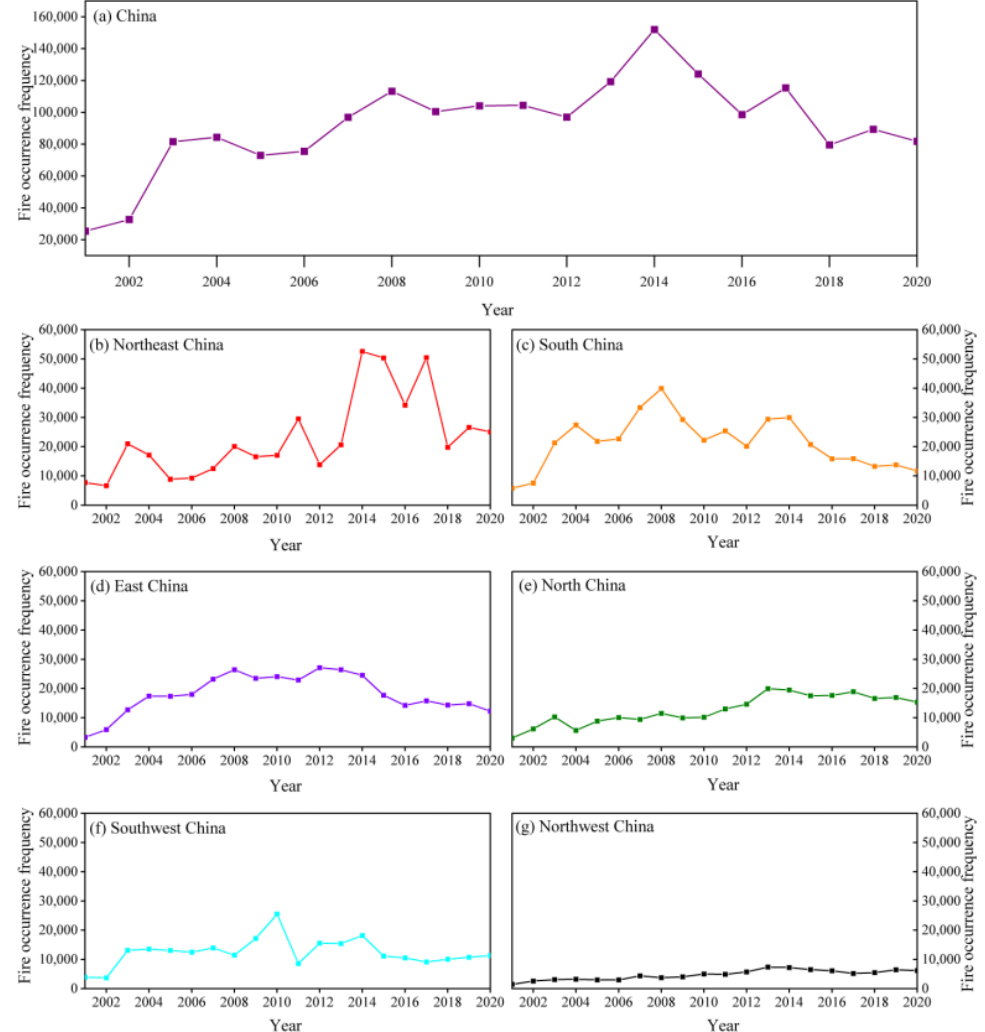
Figure 3. Total occurrence frequencies derived from MODIS C6 active fire data in ( a ) China, ( b ) Northeast China, ( c ) South China, ( d ) East China, ( e ) North China, ( f ) Southwest China, and ( g ) Northwest China during 2001 – 2020.